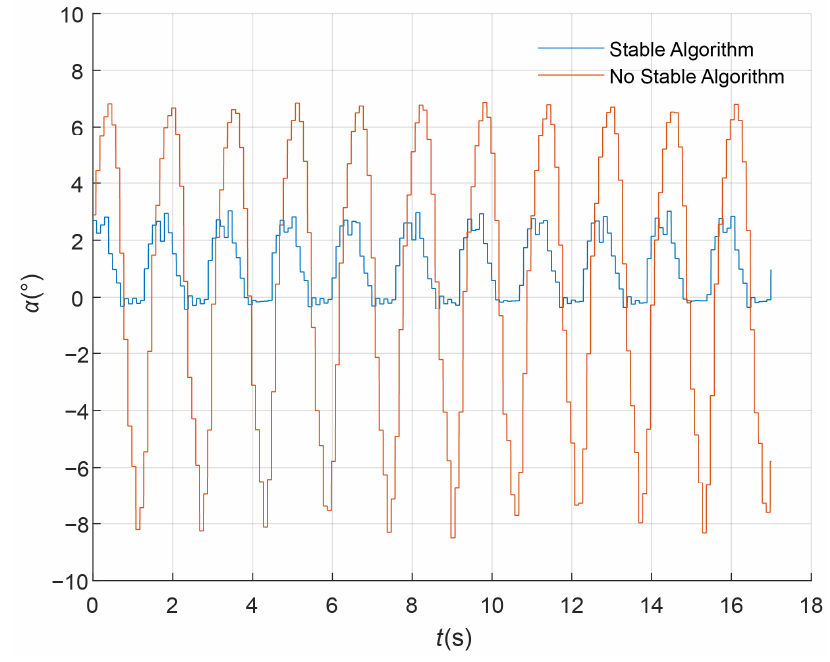
Figure 11. Head stabilization simulation data.